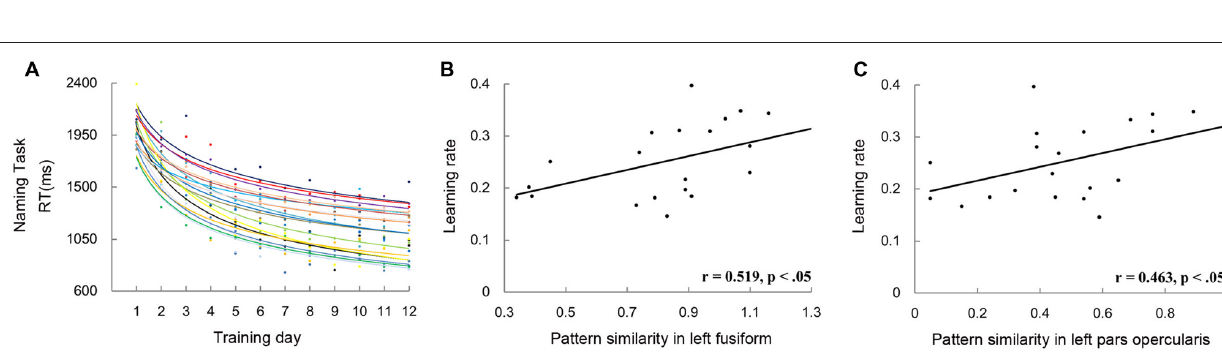
FIGURE 8 | The left graph (A) shows the scatter plot and fitted learning curve for each participant. The naming speed in each training day was calculated by averaging the RTs of the word and picture naming tasks. The two scatter plots on the right show correlations between learning rate and pattern similarity of artificial languages words in the left FG (B) and PO (C) .